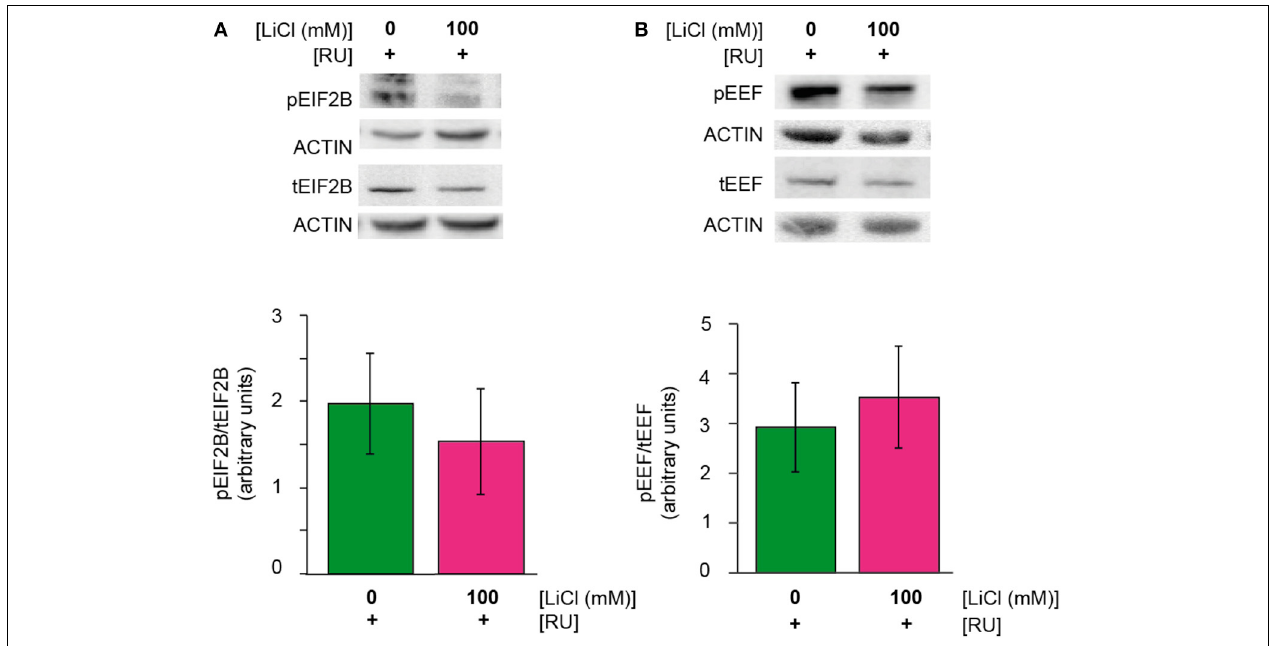
FIGURE 4 | (A,B) Lithium reduced protein levels of phosphorylated and total eIF2Be and eEF-2. There was no change in the ratio of phosphorylated eIF2Be or eEF-2 to total protein levels of eIF2Be or eEF-2